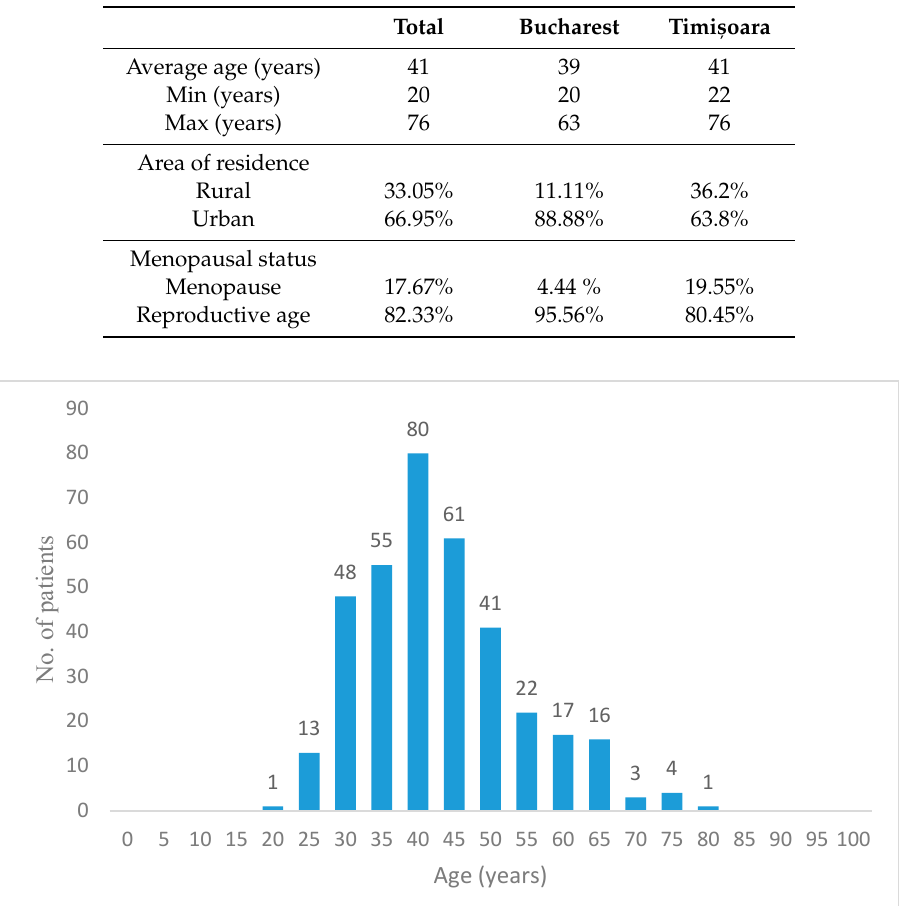
Table 1. Descriptive statistics of patient age, area of residence and menopausal status.